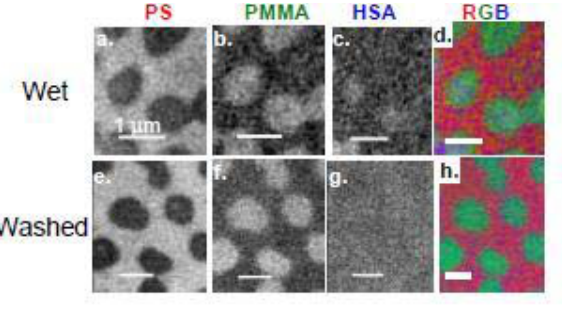
Figure 11 . (top) Component maps derived from a C 1s STXM image sequence: fully hydrated wet cell of HSA adsorbed to a PS-PMMA thin film. a) PS b) PMMA, c) HSA, d) rescaled color composite map. (bottom) Component maps from a fully hydrated sample, but washed repeatedly with DDI water prior to sealing the wet cell. e) PS, f) PMMA, g) HSA, h) rescaled color composite map. In each case, the color coding for the composite maps is (red = PS, green = PMMA, blue = HSA). HSA = [0.005 mg/mL]. [36]. (reproduced with permission of the